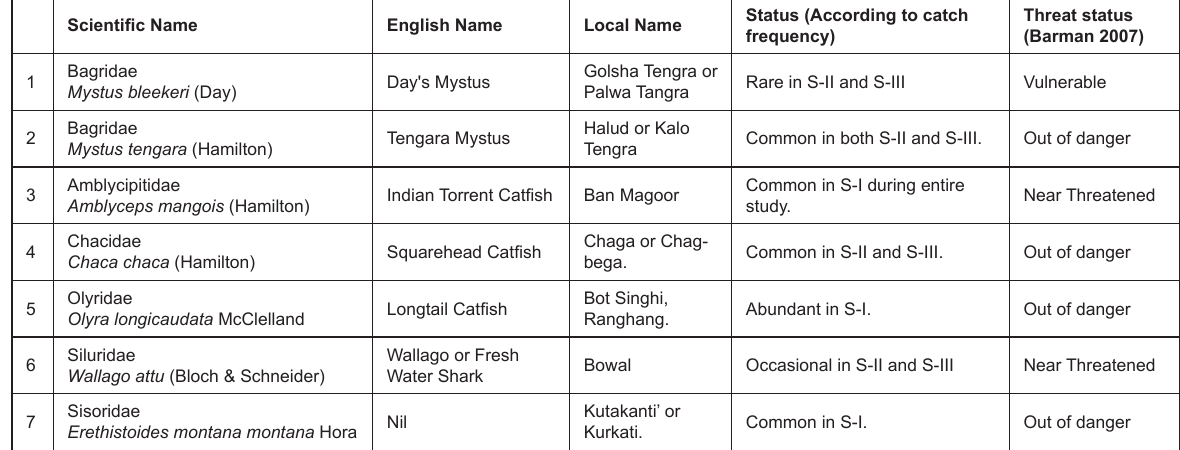
Table 1. Species diversity of cat fishes and their local name, status and fishery